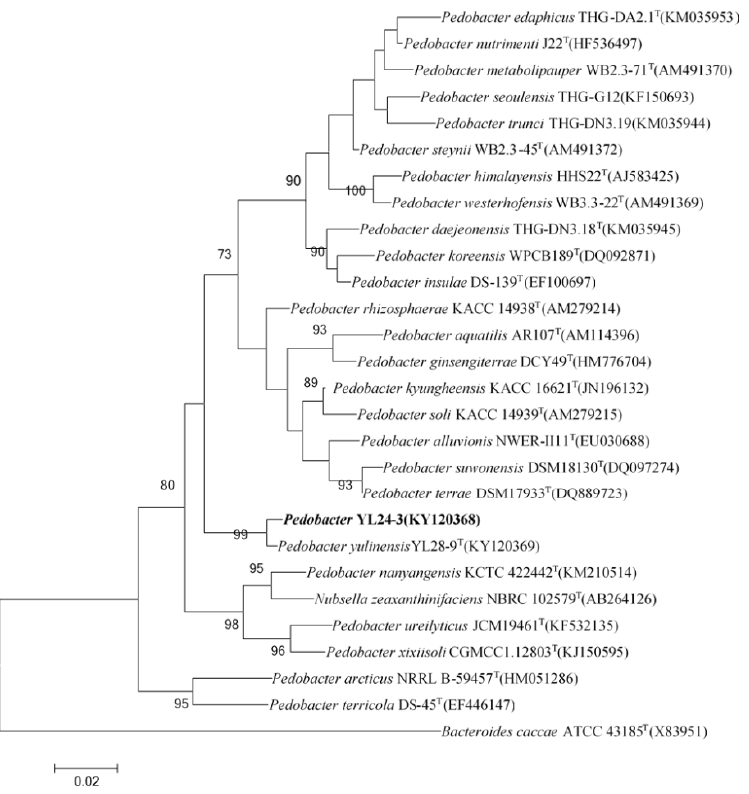
Figure 1. Neighbor-joining tree based on the 16S rRNA gene sequences of strain YL24-3 and related taxa. Bootstrap values are based on 1000 replicates. Only values >70% are shown. Bar, 0.02 substitutions per nucleotide position. The 16S rRNA gene sequence from Bacteroides caccae ATCC 43185T was used as the out group.